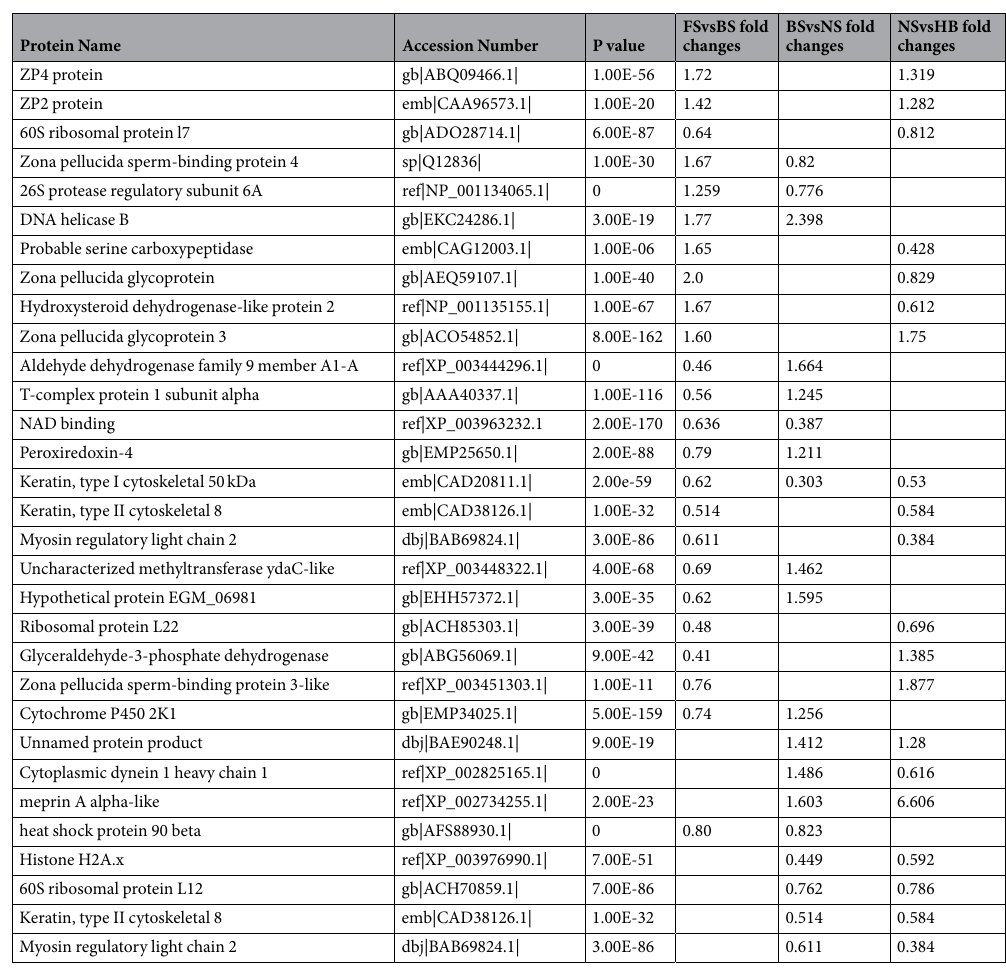
Table 1. List of intersection differentially expressed proteins (intersection DEPs) in A. schrenckii proteome. Intersection DEPs were identified as differentially expressed in at least two of the comparisons. FS: Fertilized